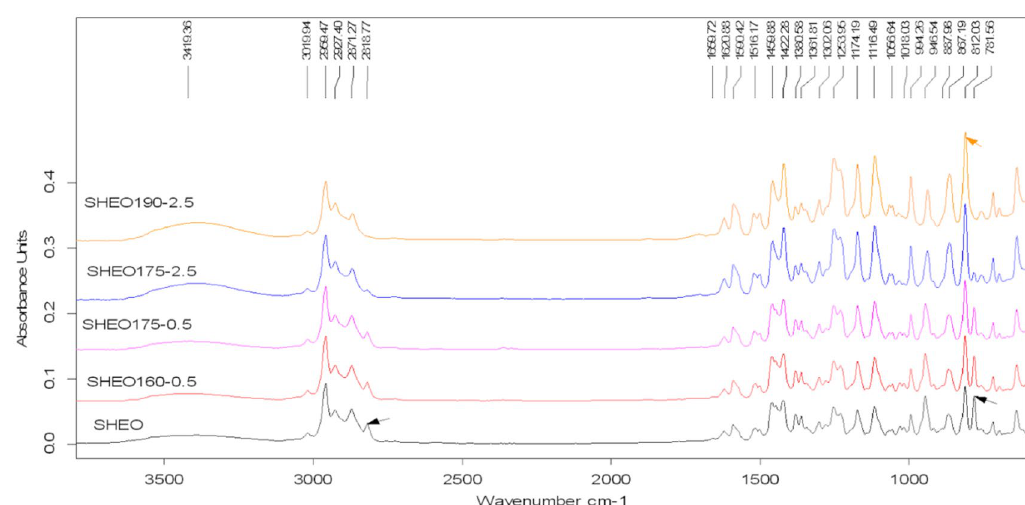
Figure 3. ATR-FTIR spectra recorded for S. hortensis essential oil samples. Annotations are as for Fig.